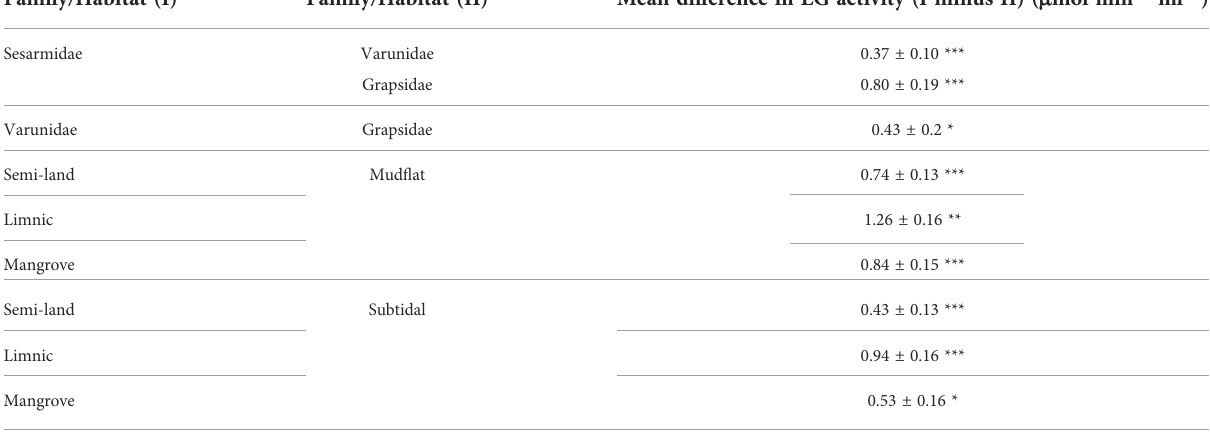
TABLE 3 Comparison of EG activity in crabs from different families and habitats. Family / Habitat (I)